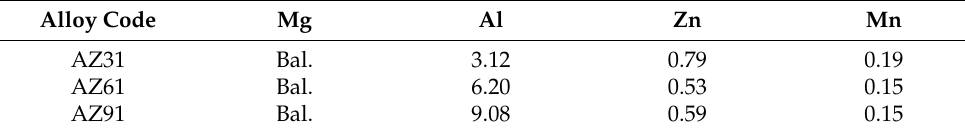
Table 1. Chemical composition of AZ-series magnesium alloy (wt.%). Alloy